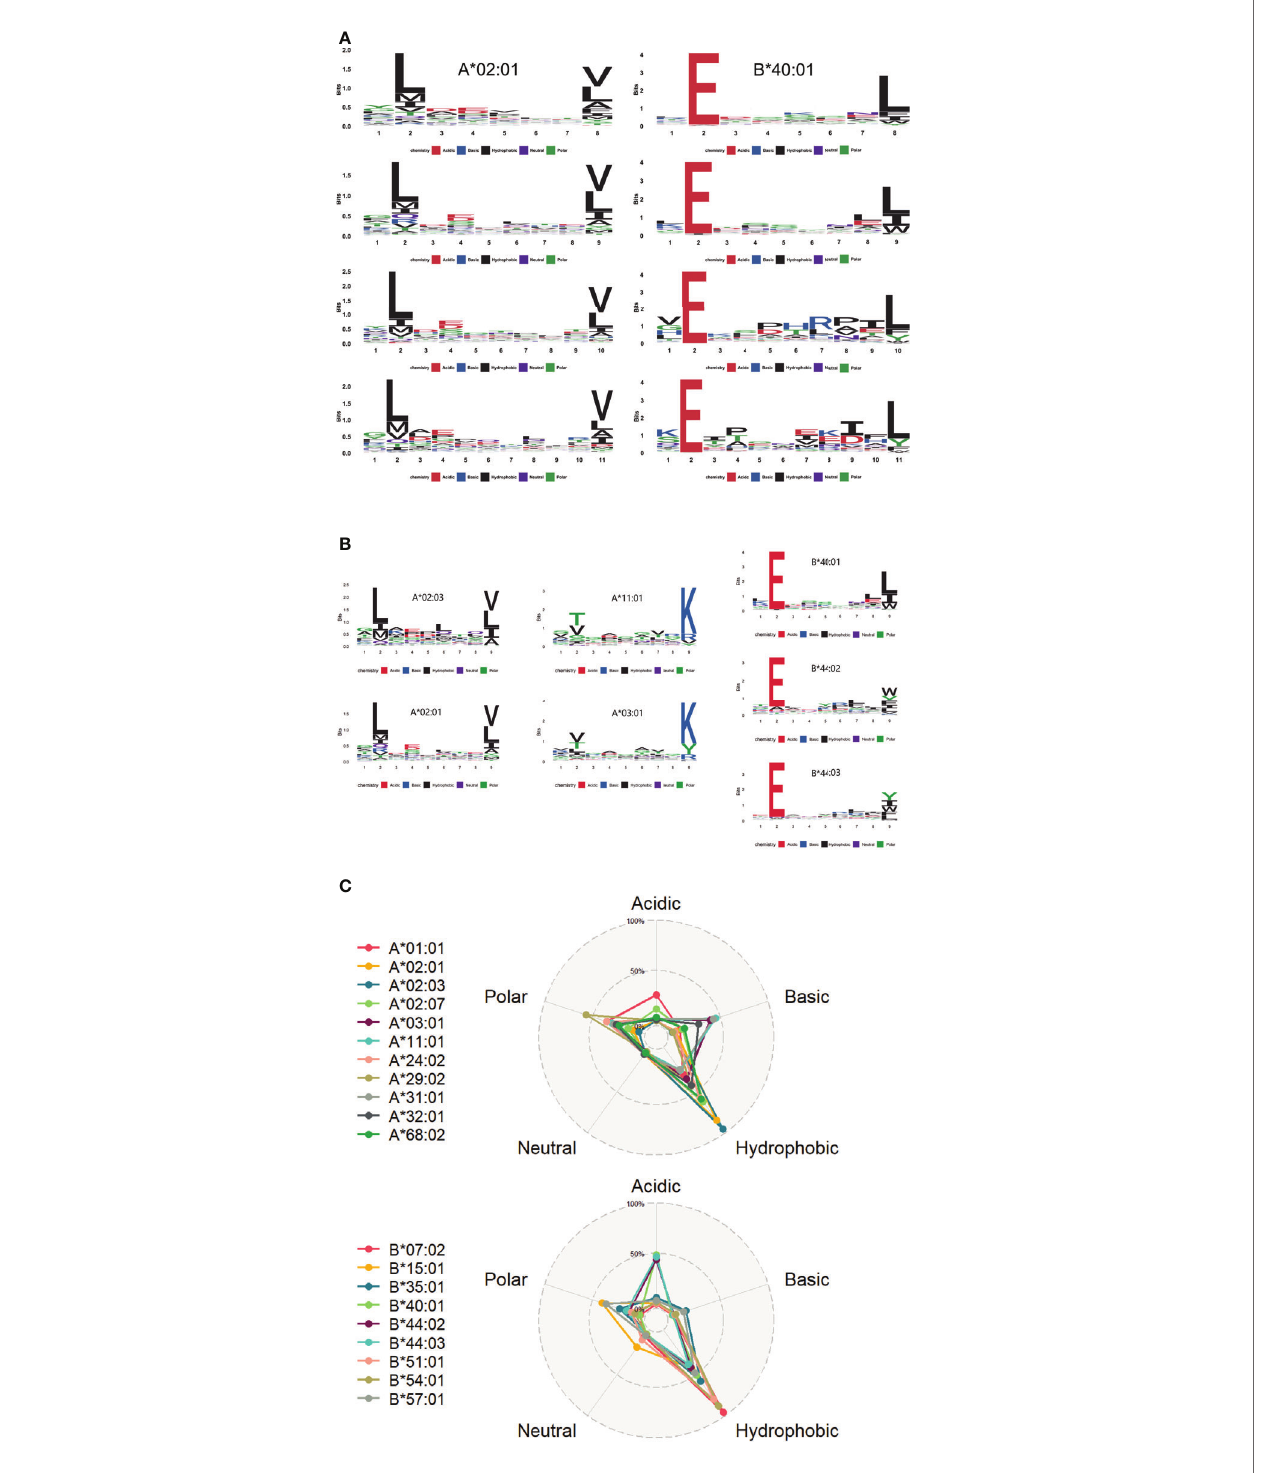
FIGURE 4 | ThemotifofHLAalleles (A) ThelearneddependenceofHLApresentationoneachsequencepositionforpeptidesoflengths8 – 11.Thered,blue,black, purple,andgreenlinesrepresenttheacidic,basic,hydrophobic,neutralandpolaraminoacidsrespectively. (B) Somesimilarmotifsaredepictedinthisgraph. (C) The radarviewisadeformationofthepercentagegraphillustratingthemotifsofHLA-AandHLA-Battheoveralllevel.DifferentcolorsrepresentvariedHLAclassImolecules. Allelesde fi